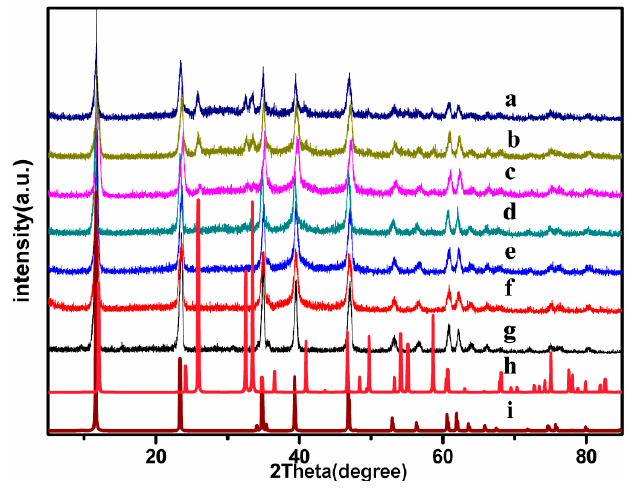
Figure 1. Powder XRD patterns of ( a ) Pt–9Bi/HT, ( b ) Pt–7Bi/HT, ( c ) Pt–5Bi/HT, ( d ) Pt–3Bi/HT, ( e ) Pt–1Bi/HT, ( f ) Pt/HT, ( g ) HT, ( h ) BiOCl, ( i ) Mg 4 Al 2 (OH) 12 CO 3 ∙ 3H 2 O. HT: hydrotalcite.